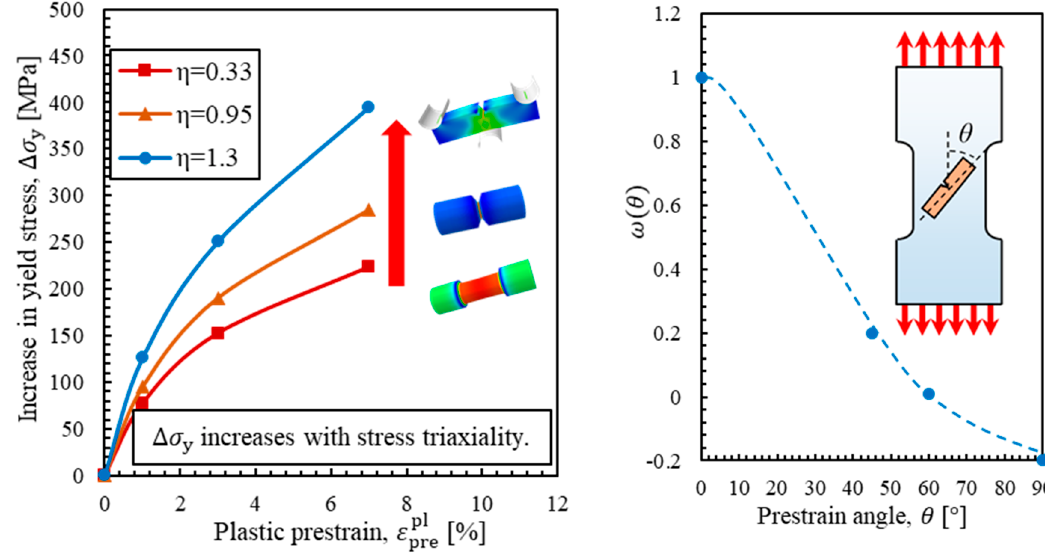
Figure 10. Introduction of coefficients of the proposed elastic component. ( a ) Effect of triaxiality on the increase in yield stress under monotonic prestrain, ( b ) 𝜔(𝜃) .